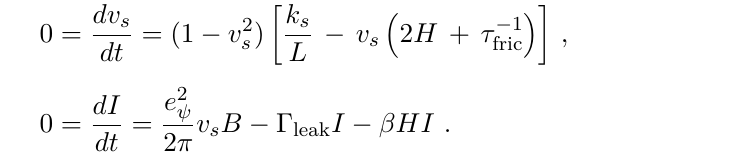
is taken to be 10 10 a